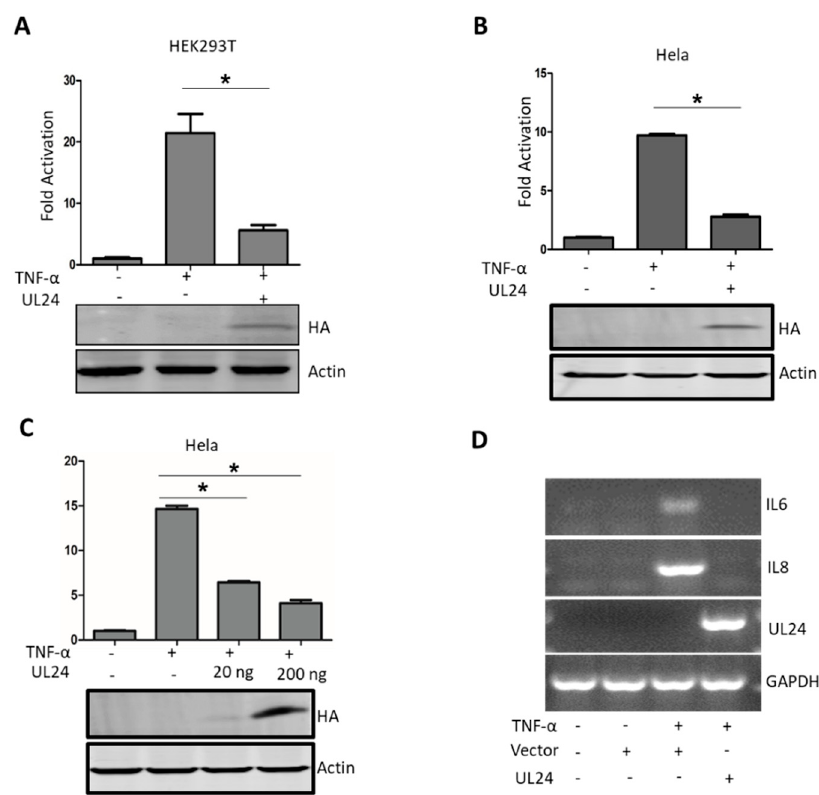
Figure 1. Pseudorabies virus (PRV) UL24 dampens TNF- α -mediated NF- κ B activation. ( A ) HEK293T cells and ( B ) HeLa cells were co-transfected with an NF- κ B-Luc reporter plasmid, the pRL-TK plasmid (transfection control), along with a UL24 plasmid or an empty vector. Luciferase activity was measured